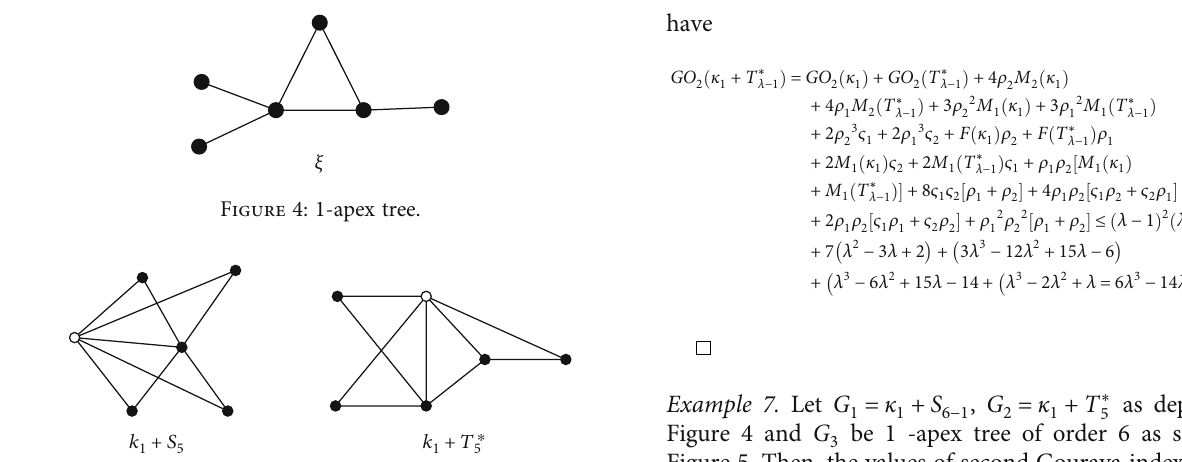
-apex trees are GO 2 ð G 1 Þ = 810 , GO 2 ð G 1 Þ = 720 , and GO 2 ð G = 214 . Table 2 depicts the values second Gourava index 1 Þ of some graphs in the class of 1 -apex trees of order 8.